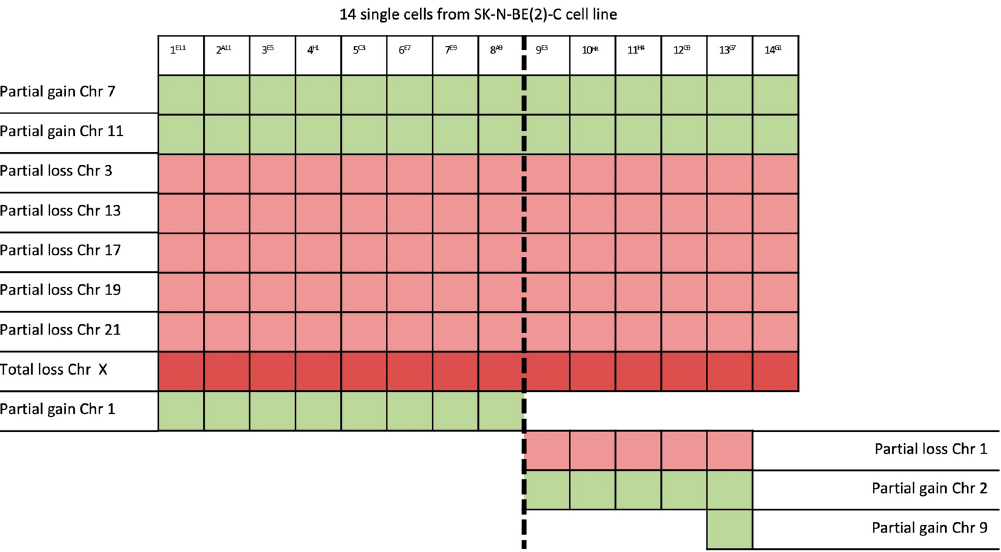
Figure 6. CNV evaluation of all 14 isolated single cells from SK-N-BE (2)-C revealed the existence of two main subpopulations within the same cell line and four different chromosomal patterns: (I) from Sample 1–Sample 8; (II) Samples 9 and 12; (III) Sample 13; (IV) sample 14.